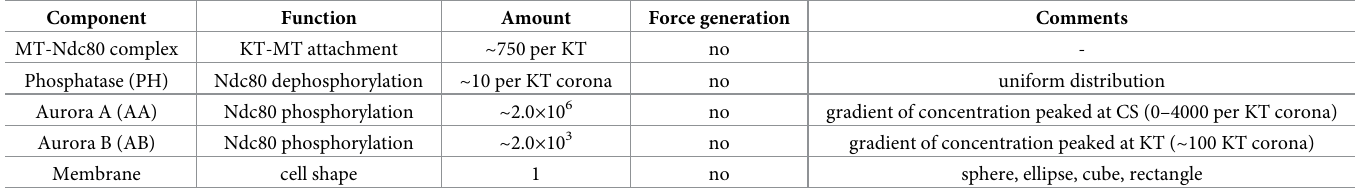
Table 2. Components of CellDynaMo described with Reaction-Diffusion Master Equation formalism. Functional role and the number of copies of each component described with RDME, including MT-Ndc80 complex, Phosphatase enzyme (PH), Aurora A enzyme (AA), Aurora B enzyme (AB), and cellular membrane. Also provided is the information about the force-generating properties and the distribution of each component inside the